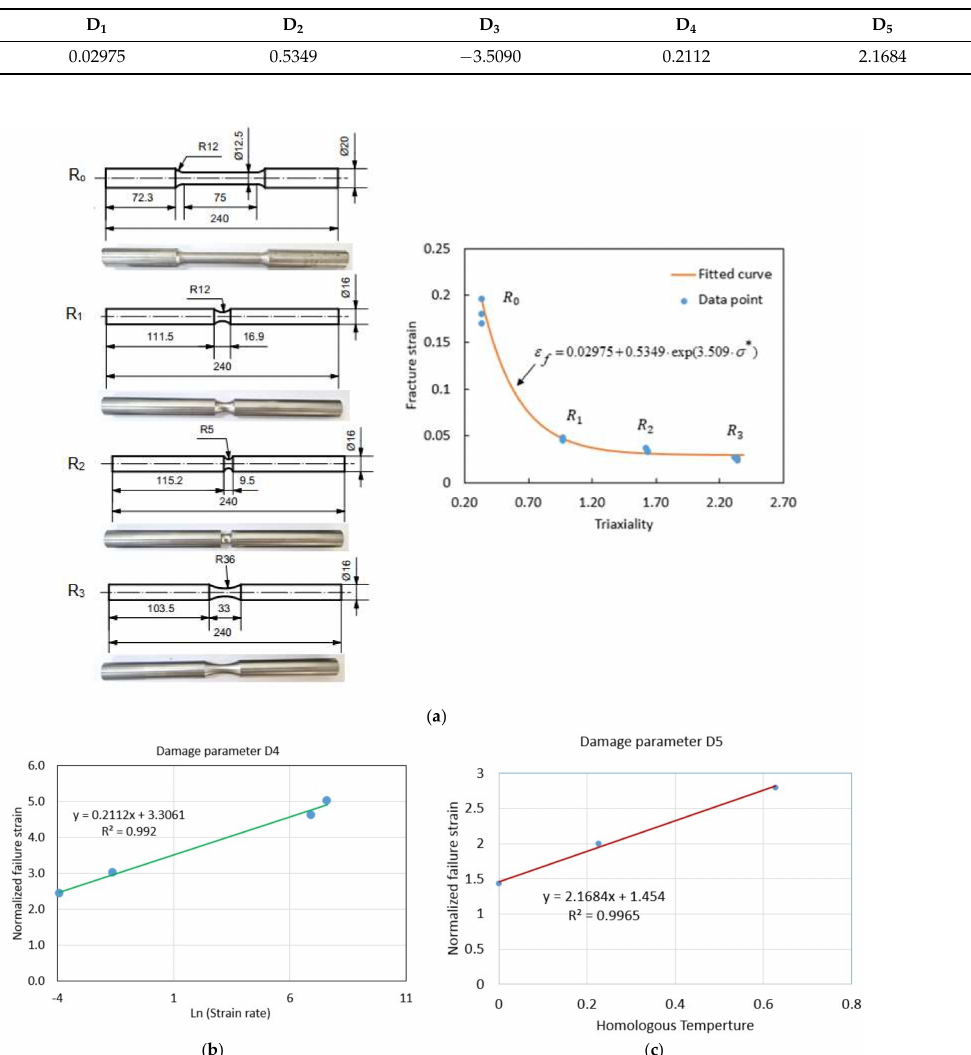
Table 3. The coefficients of J-C fracture model for SKD11 alloy steel material.